Question: Provide a one-line summary of what is displayed.
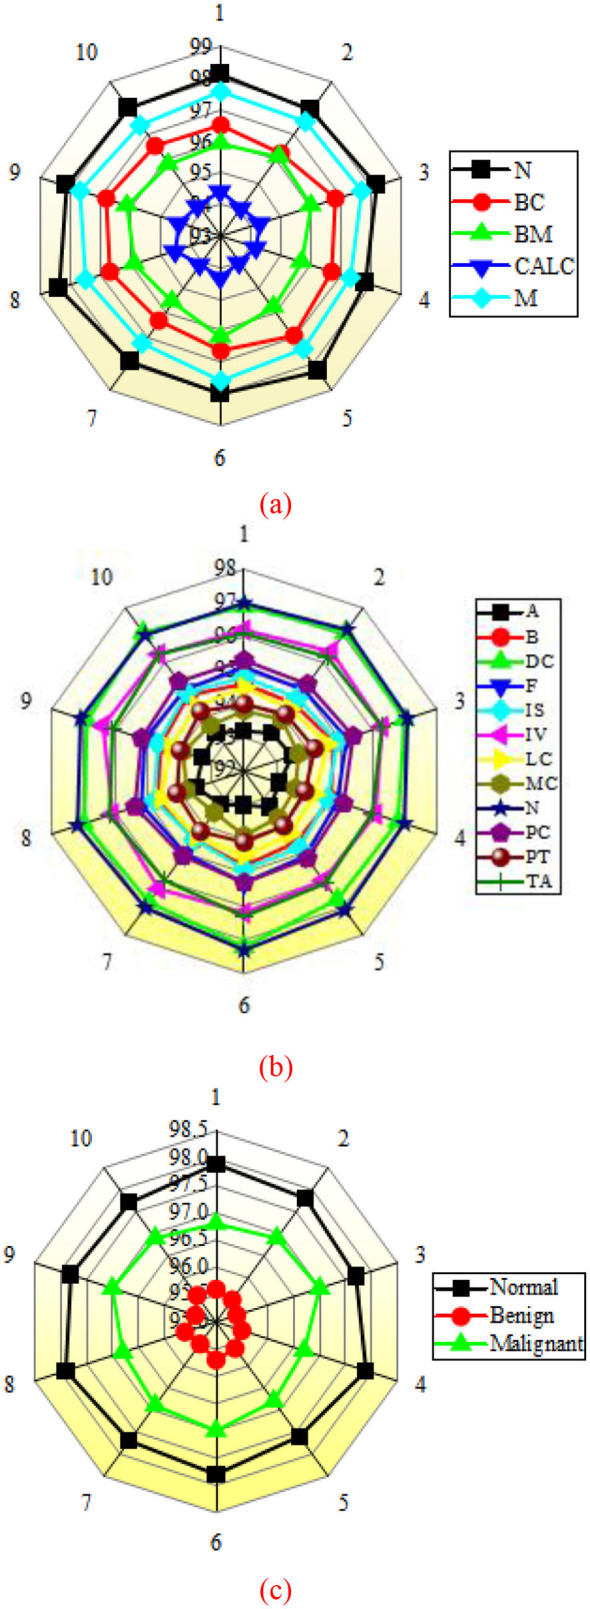
Answer: Class-wise accuracy results of LCNN model for breast cancer diagnosis on (a) MIAS, (b) BreakHis, and (c) multimodal datasets over 10-fold cross-validation.